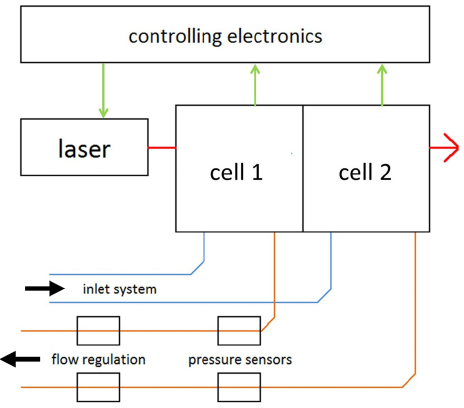
Figure 1. Schematic layout of the photoacoustic system. Green, red and black arrows indicate the electronic communication, laser beam propagation and gas flow directions, respectively. Blue and orange lines represent heated gas input and unheated gas output tubes, re-